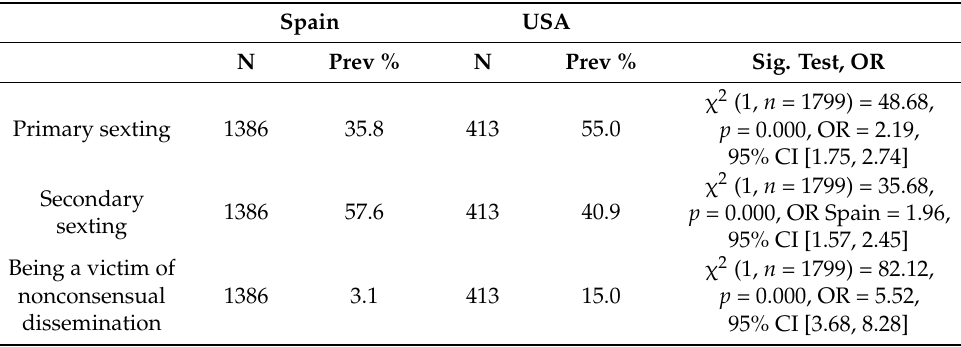
Table 2. Prevalence of sexting behaviors for the total sample by